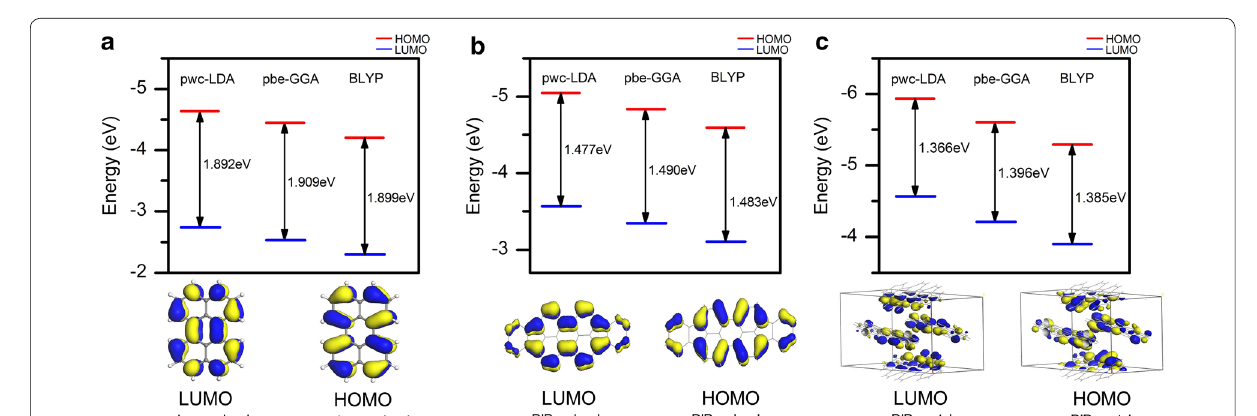
Fig. 2 Graph of energy gaps and HOMO–LUMO of a perylene molecule, b DIP molecule and c DIP